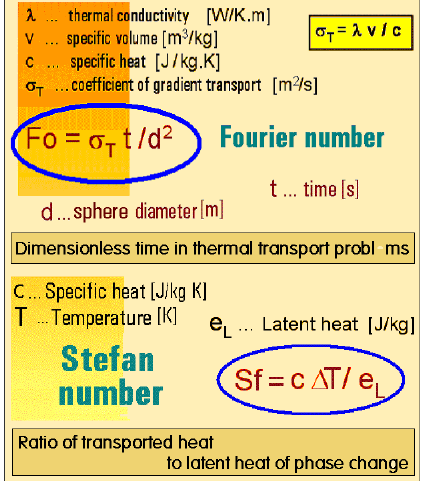
Fig. 21. Dimensionless parameters Fo and Sf. Their product Fo.Sf , was expected — as discussed in [3] — to be of fundamental importance in the search for the universal law of the melting process.